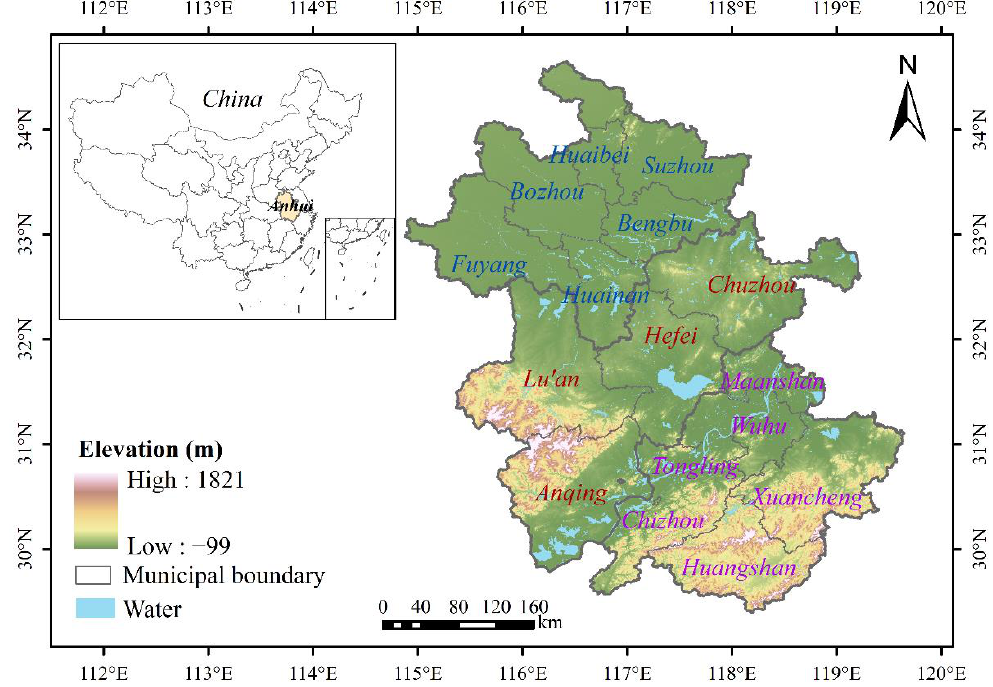
Figure 1. Elevation map of the Anhui Province study area. Note: Blue characters represent northern Anhui, red characters represent central Anhui and purple characters represent southern Anhui.